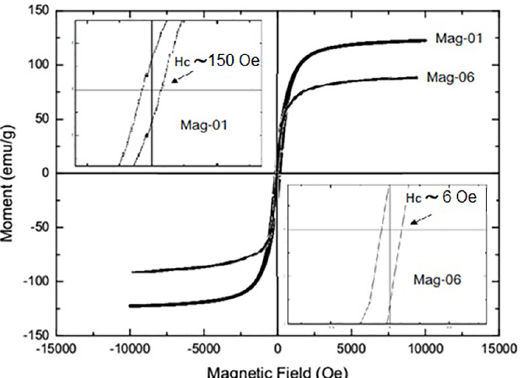
Figure 5. Hysteresis curves of samples Mag-01 and Mag-06